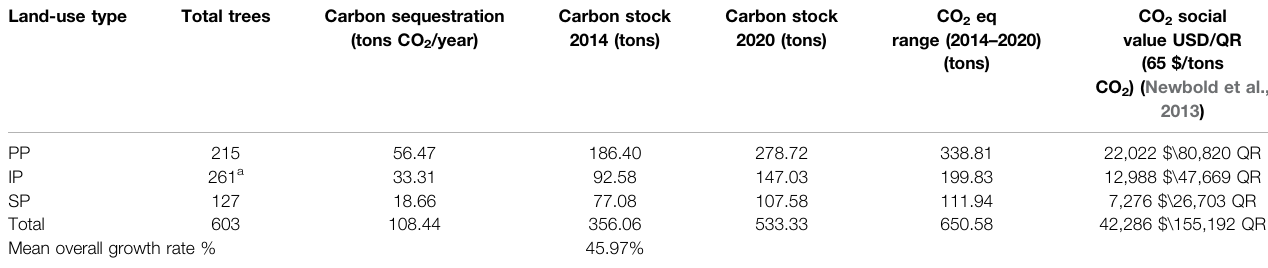
TABLE 9 | A comparison of total carbon stock in the selected areas measured from vegetative indices and above-ground carbon between the years 2014 and 2020. Land-use